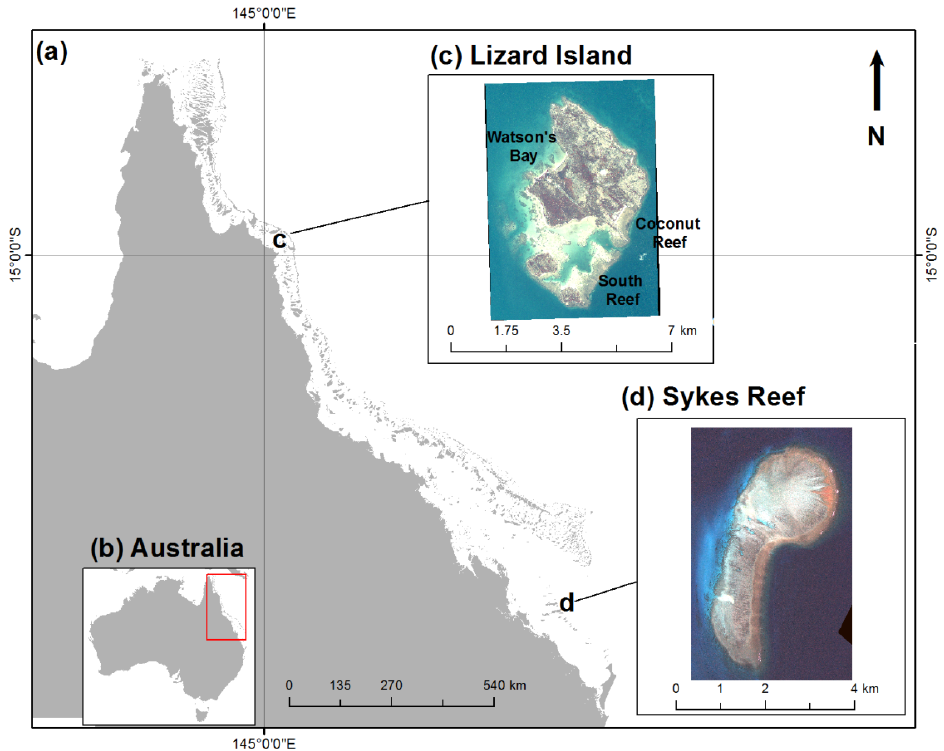
Figure 1. Locations of study sites selected for analysis of bathymetry models (from left to right): ( a ) Queensland coastline; ( b ) Australian continent; ( c ) Lizard Island (northern Great Barrier Reef, GBR); and ( d ) Sykes Reef (Capricorn-Bunker Group, southern GBR).